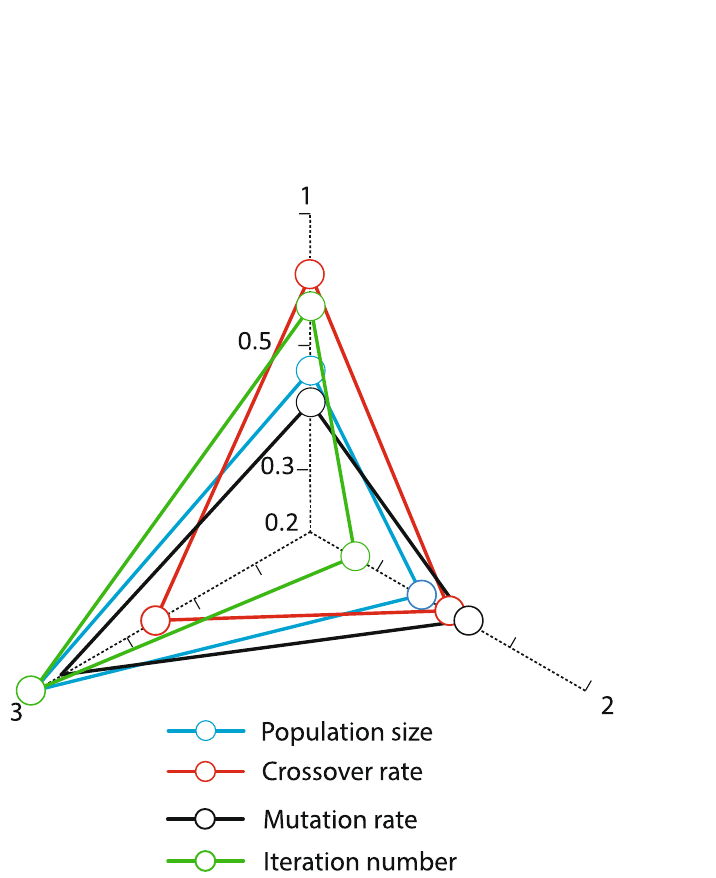
Figure 8. The average effect in NSGA